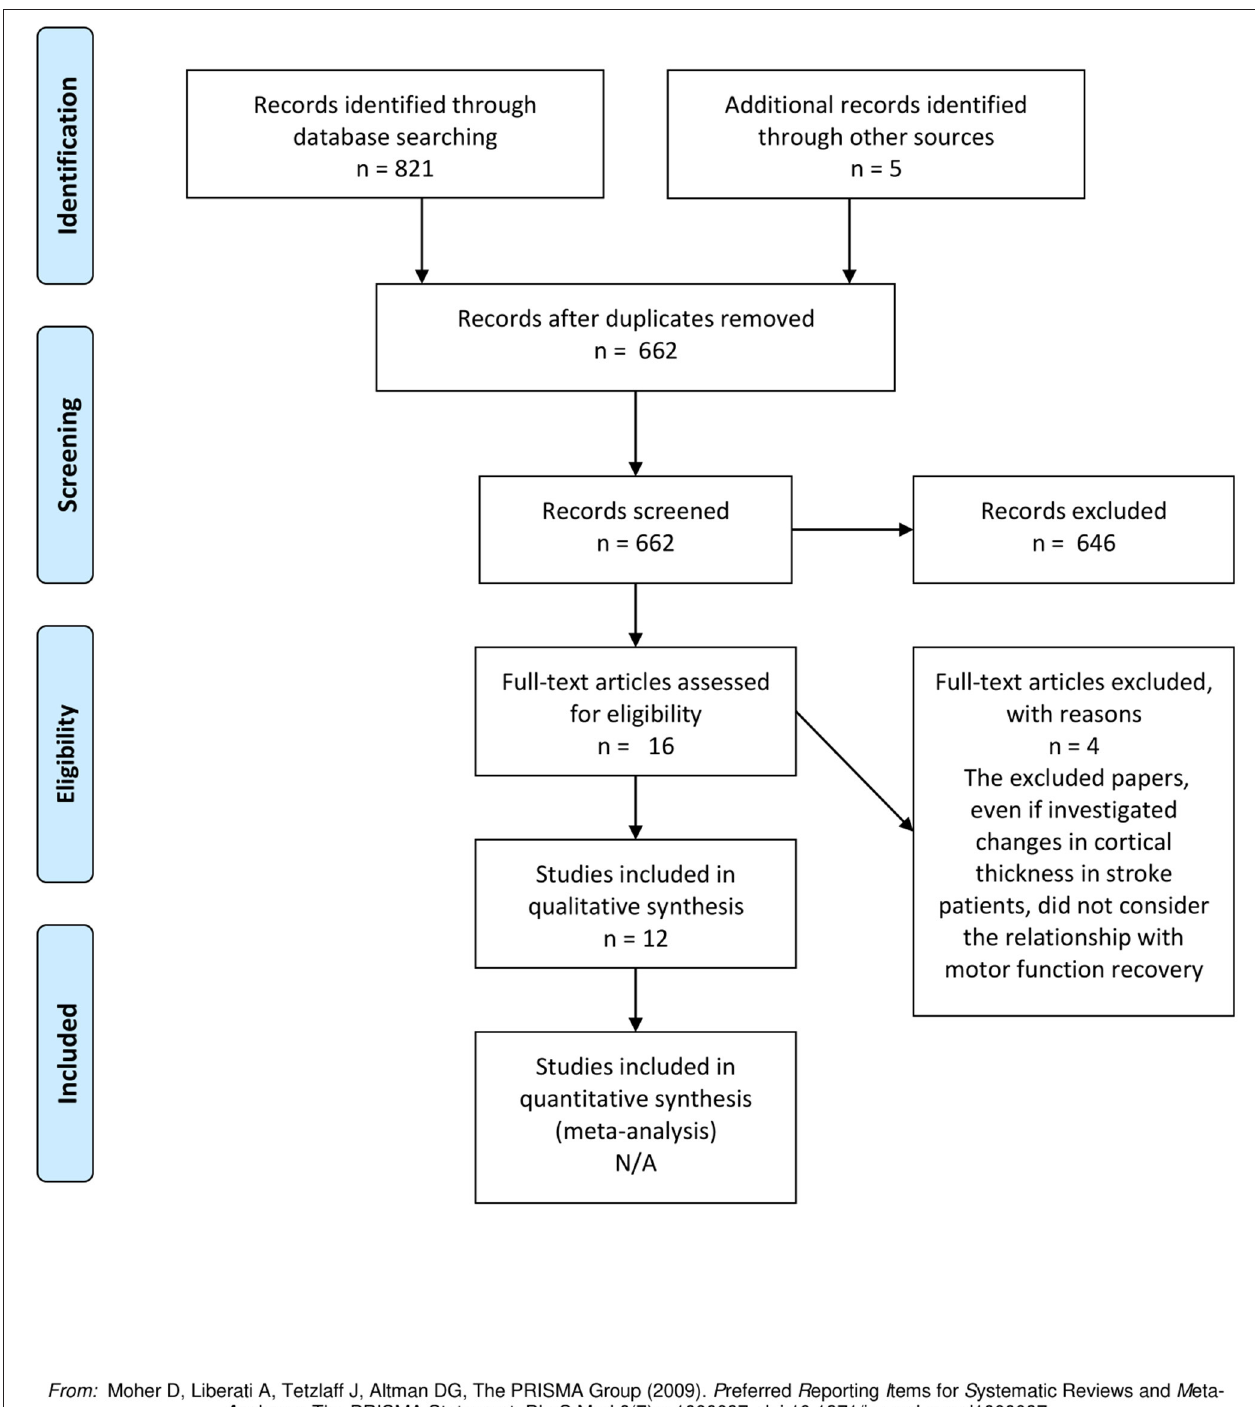
FIGURE 1 | Flow diagram of the